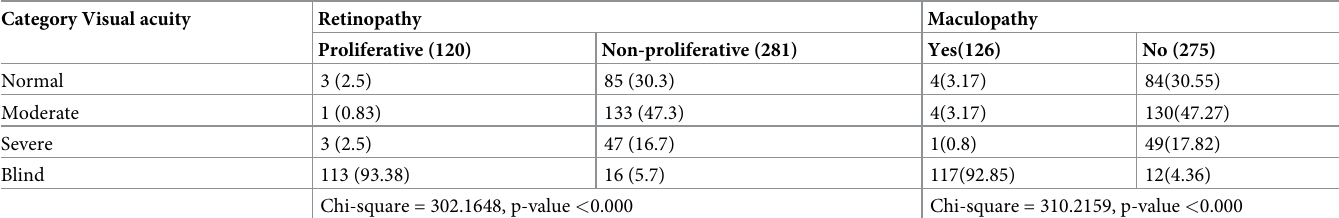
Table 4. Retinopathy and maculopathy concerning visual acuity. Category Visual